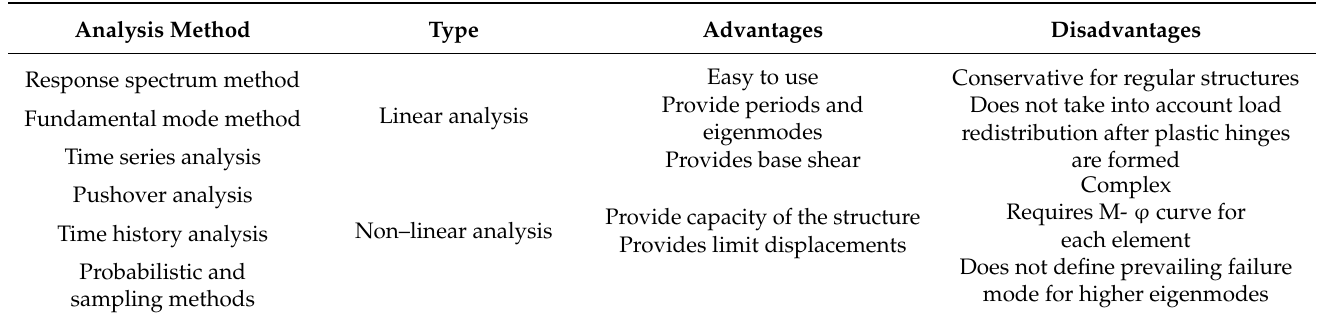
Table 2. Analysis methods for seismic assessment of existing RC